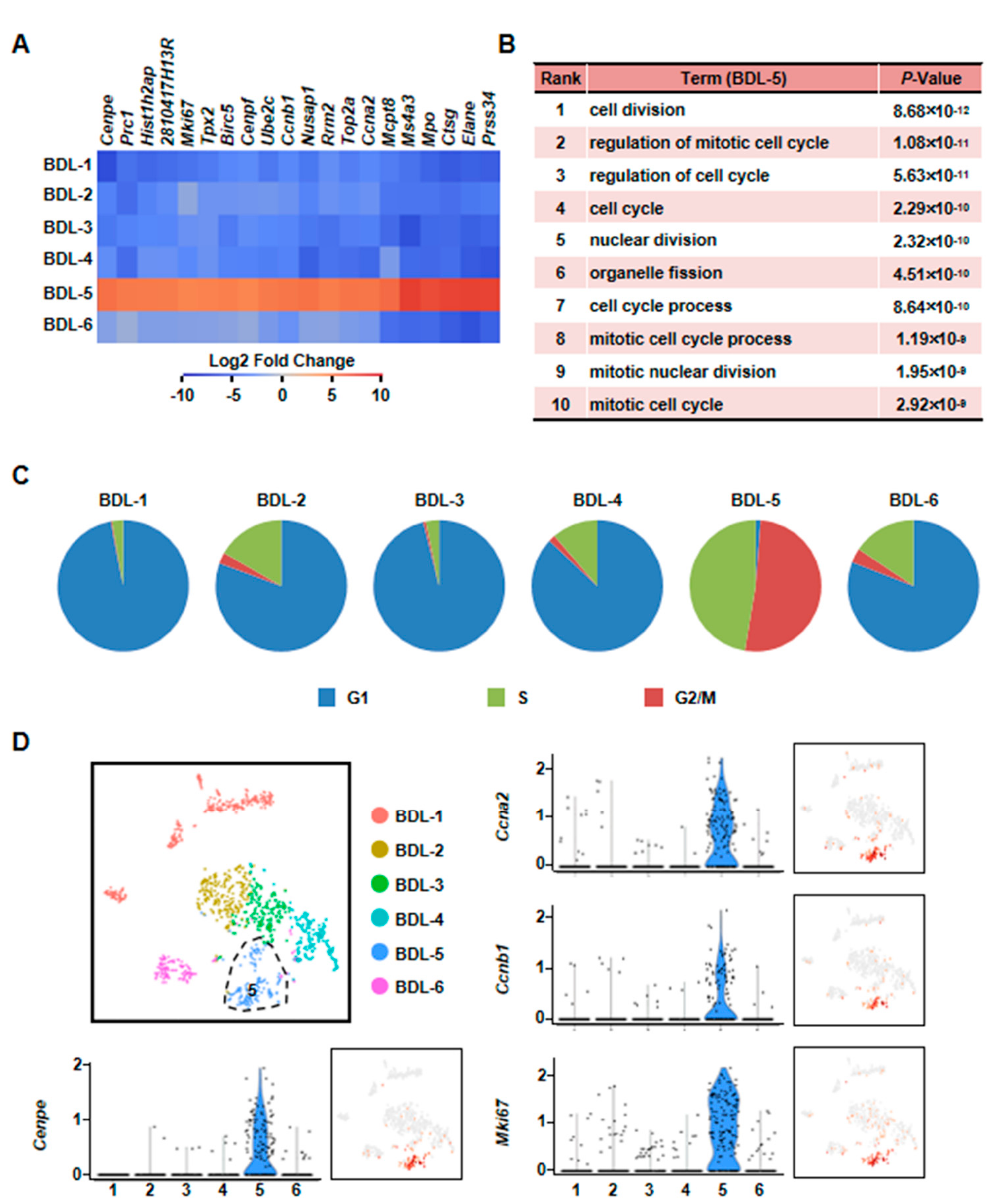
Figure 7. Characterization of proliferative hepatocyte cluster. ( A ) Heatmap showed top 20 highly expressed genes of BDL-5. ( B ) GO analysis of BDL-5 highly expressed genes. ( C ) Cell cycle analysis of six clusters of BDL sample. ( D ) Enrichment pattern of genes in BDL-5.